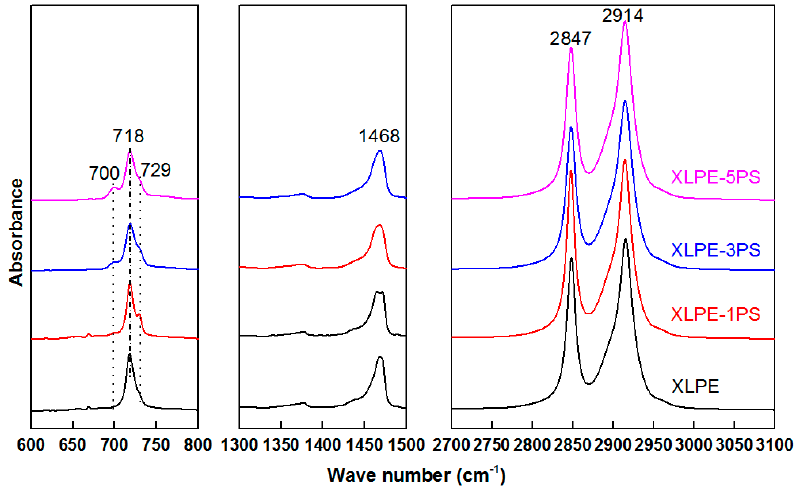
Figure 5. FTIR spectra of the gel for samples.